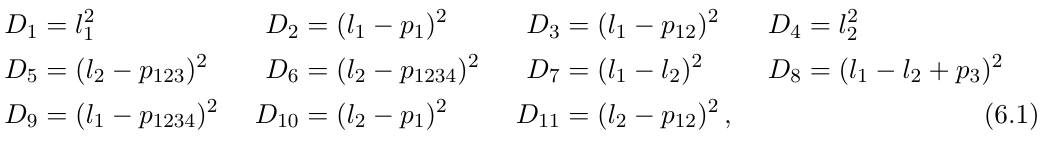
Figure 7 . We depict the two-loop (cid:12)ve-point nonplanar double pentagon diagram, writing z i for the Baikov variables, which are equal to the inverse propagators. In particular, z 1 = l 2 We also draw the 11 spanning cuts of this integral family. These correspond to the non-collapsible master integrals, before using